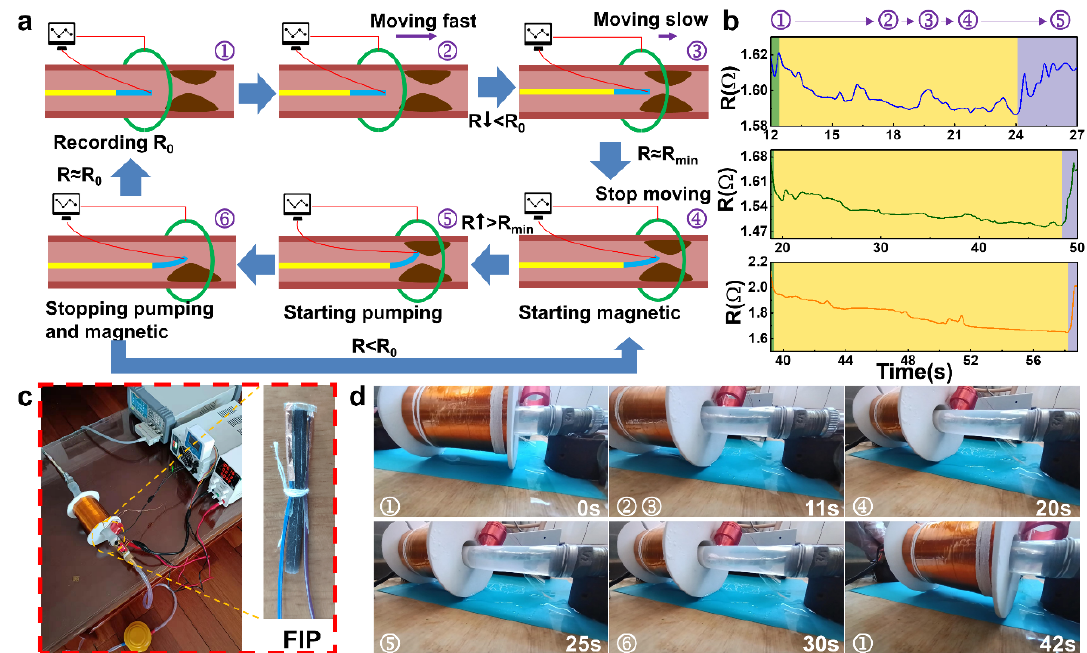
Figure 4. Simulation experiments of the FIP: ( a ) Workflow diagram of the FIP: ① initial state; ②, ③ fast monitoring; ④ intelligent positioning; ⑤ pumping and clearing; ⑥ end and next monitoring, ( b ) Sensing feedback curves in the simulation experiments, ( c ) Experimental testbed for thrombus simulation and real FIP, ( d ) Experimental procedure during simulated thrombus removal.